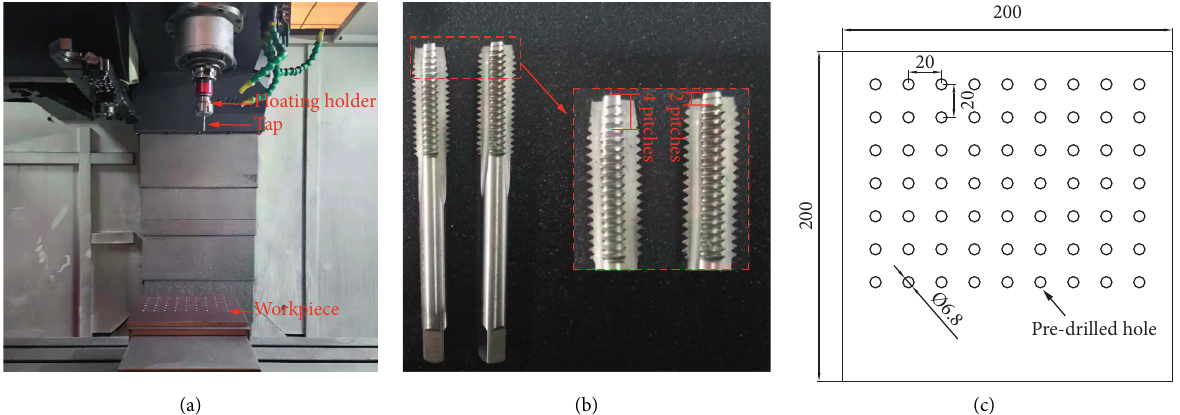
Figure 2: Machine tool and materials. (a) VMC850 vertical machining center. (b) Straight flute taps with different chamfer lengths. (c) Sample specification.